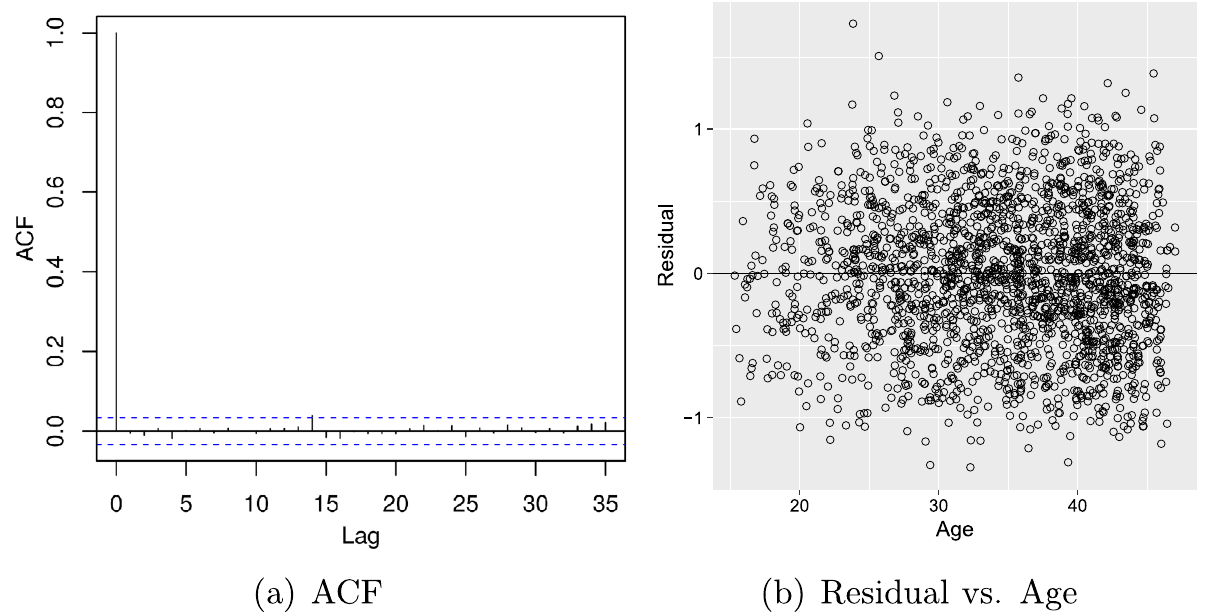
Figure 4. ( a ) Residual autocorrelation plot, and ( b ) residual versus age.